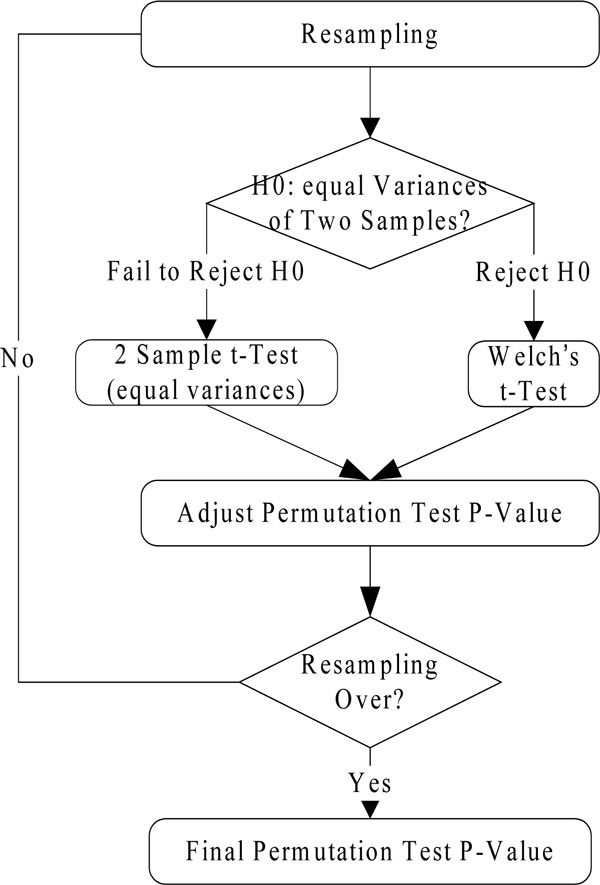
flowchart of permutation test.